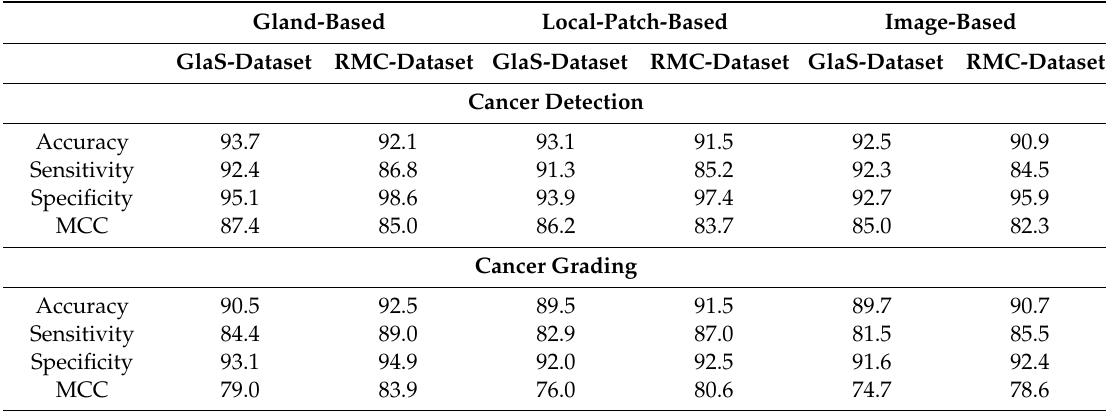
Table 2. Performance of individual feature extraction methods (results are shown for the ensemble classifier for the patch-based